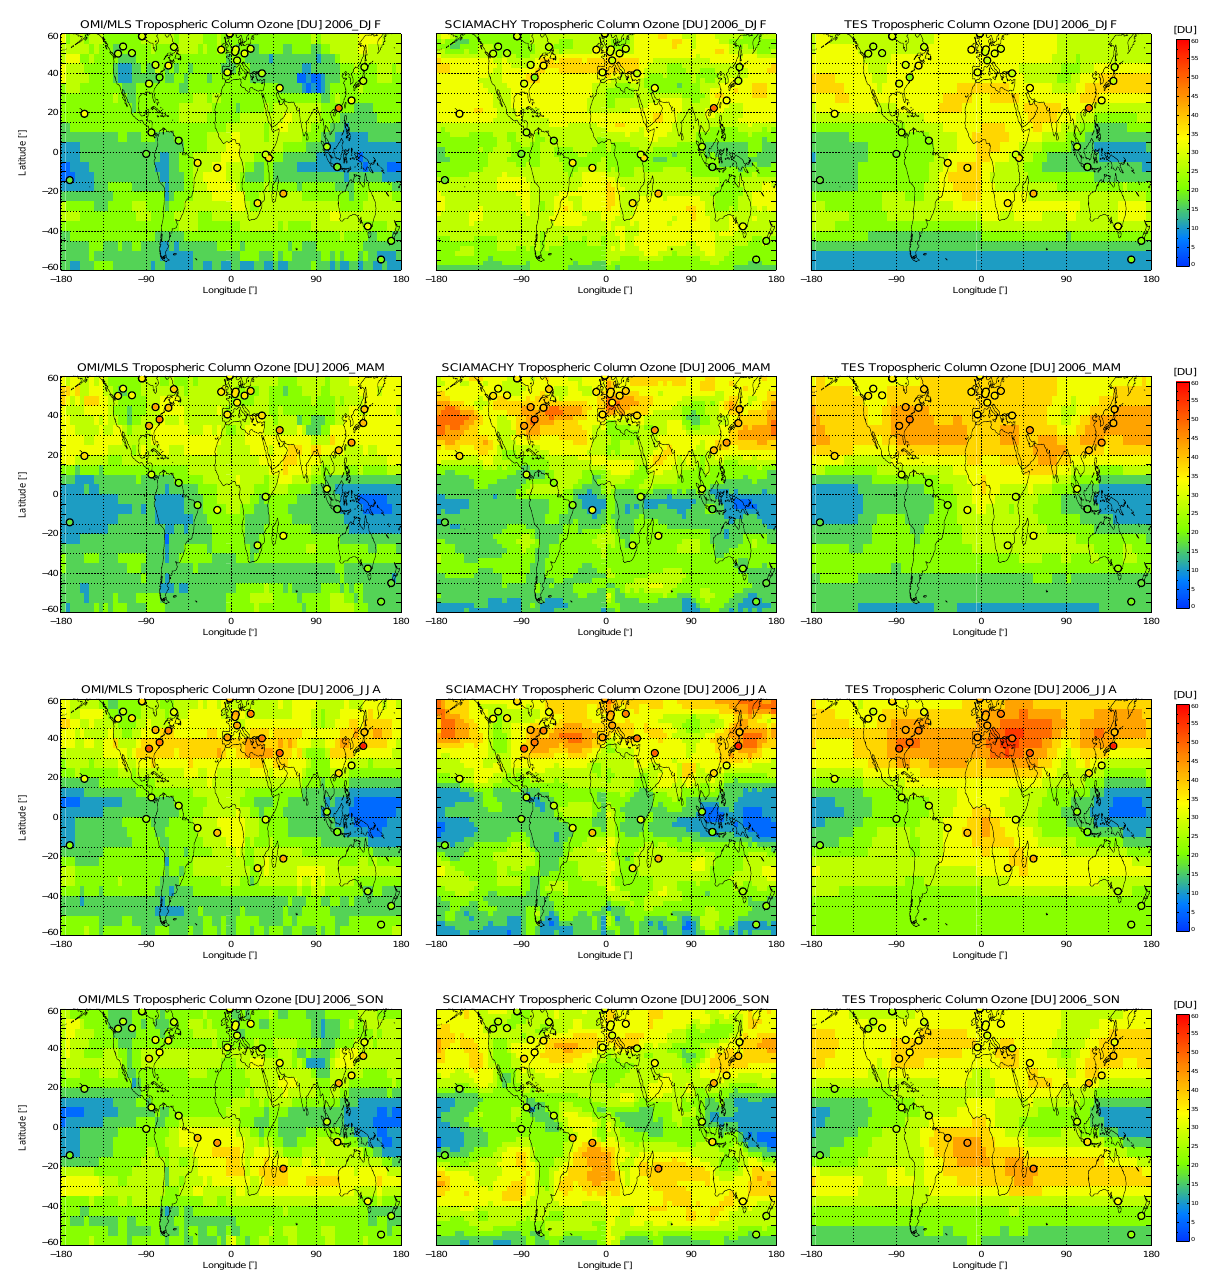
Figure 15. A comparison of the tropospheric ozone columns in Dobson units retrieved from left to right, from the measurements of Fig. 15: A comparison of the tropospheric ozone columns in Dobson Units retrieved from left to right; from the measurements OMI/MLS, SCIAMACHY and TES for different seasons in 2006; from the top row to the bottom row, the average composites are shown of OMI/MLS, SCIAMACHY and TES for different seasons in 2006, from the top row to the bottom row, the average composites are shown for December-January-February, March-April-May, June-July-August and September-October-November.